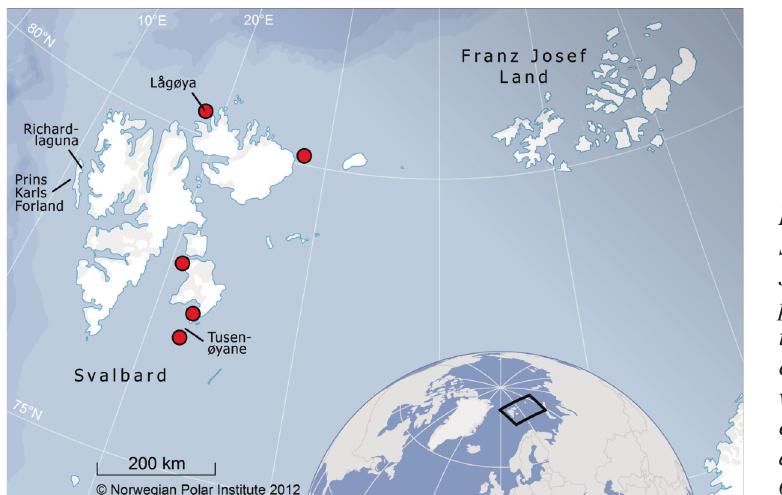
Fig. 1. Map of Svalbard and Franz Josef Land showing place names men- tioned in text. Red circles indicate where surveillance cameras are deployed (see section